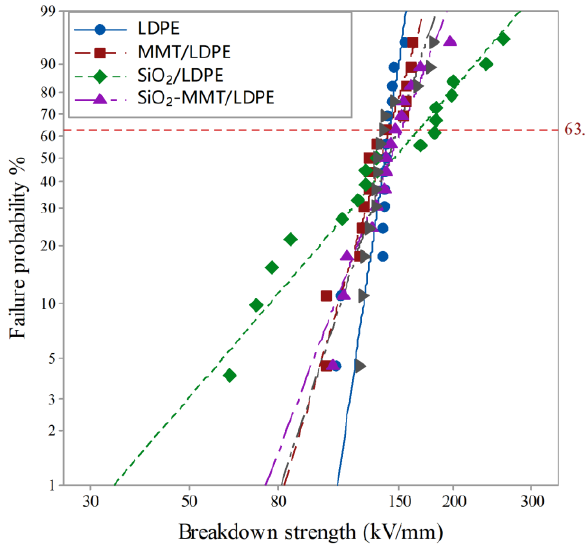
Figure 9. Weibull curve of breakdown field strength of each sample. Table 3. Characteristic breakdown field strength of each sample.